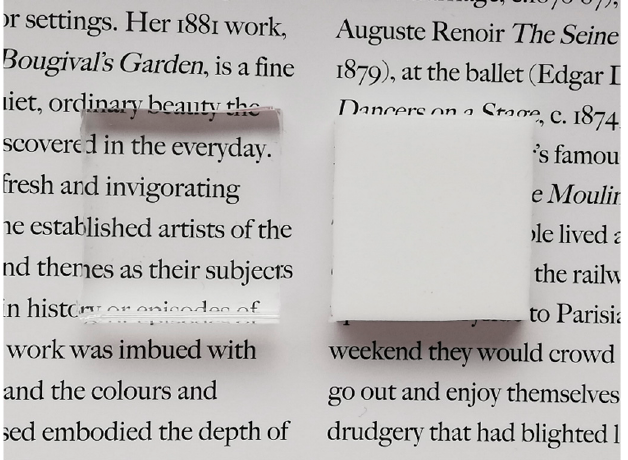
Figure 1. Pure PDMS ( left ) and PDMS with 17 wt% HGMs ( right ). Thickness of both samples is 5.8 mm.